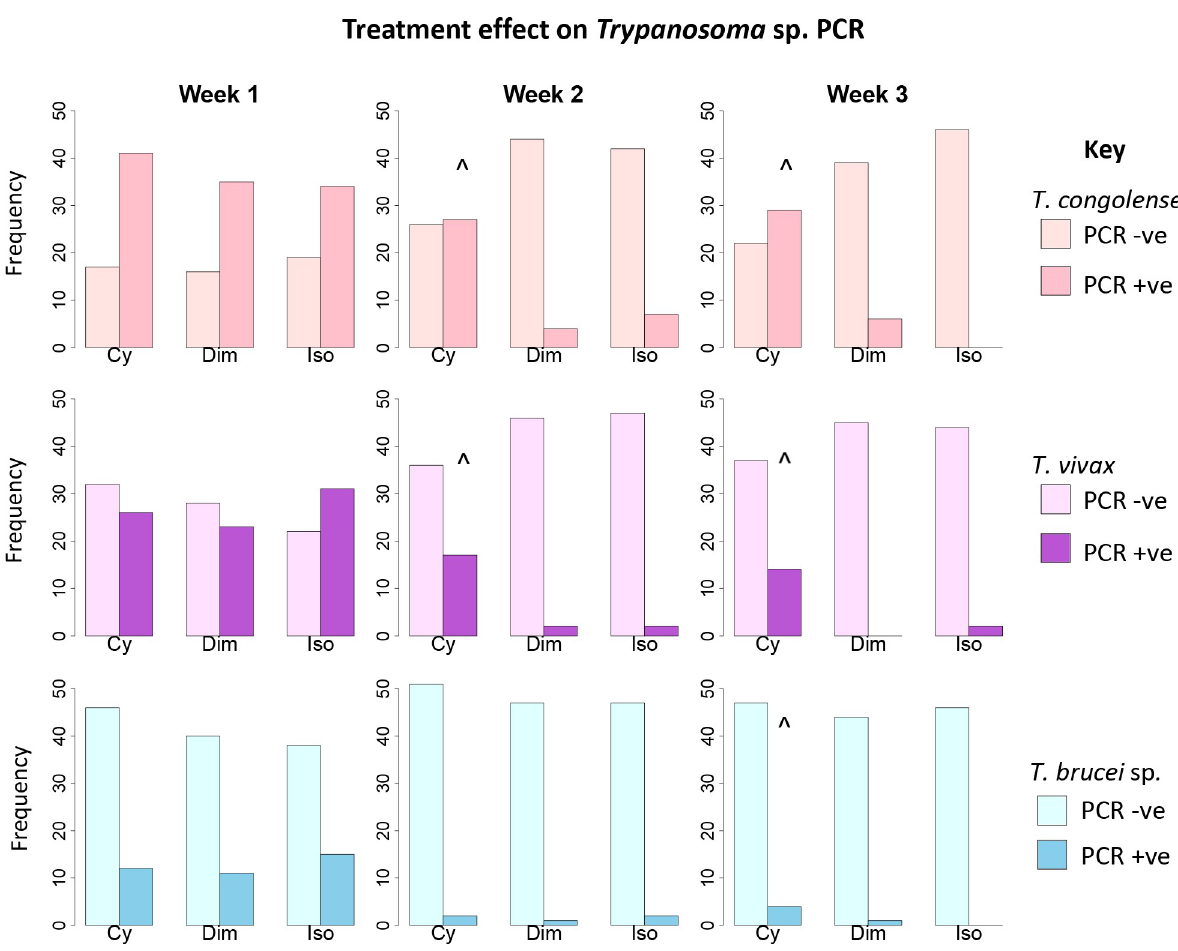
Fig 4. Bar chart lattice illustrating Trypanosoma spp. PCR status at each time point for each drug. Treatment trial group (n = 162) are subdivided by trypanocidal drug (Cy = melarsomine dihydrochloride, Dim = diminazene, Iso = isometamidium), time period (week 1, 2 or 3) and infective Trypanosoma spp. ( T . brucei sp., T . congolense or T . vivax ). ^ Denotes no significant change (p > 0.05) in PCR status from week 1. Isometamidium demonstrated a comparable effect (94–100% reduction in PCR positive status) to that reported in previous studies [24,25].